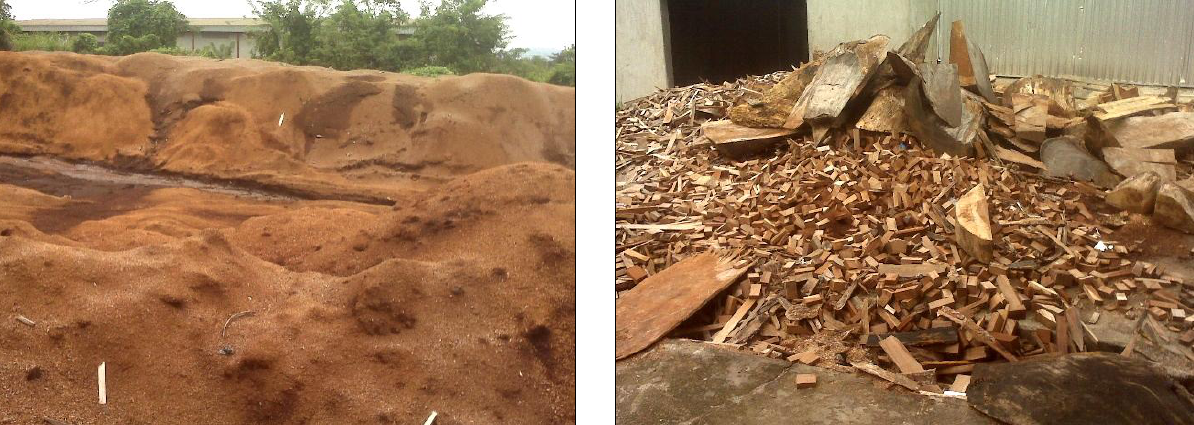
Fig. 5. Heap of sawdust and wood waste comprising of wood offcuts, wood chips and bark (left & right) at Ire Wolede sawmill, Ilorin Kwara State,